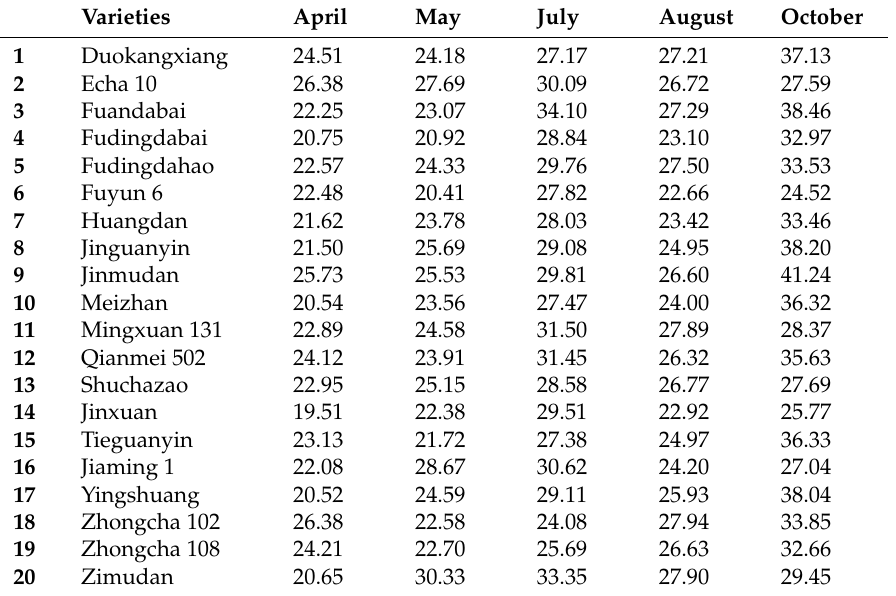
Table A2. NUtE (g / g N) in the part of one bud with two leaves for the twenty tea varieties over the entire growing seasons.